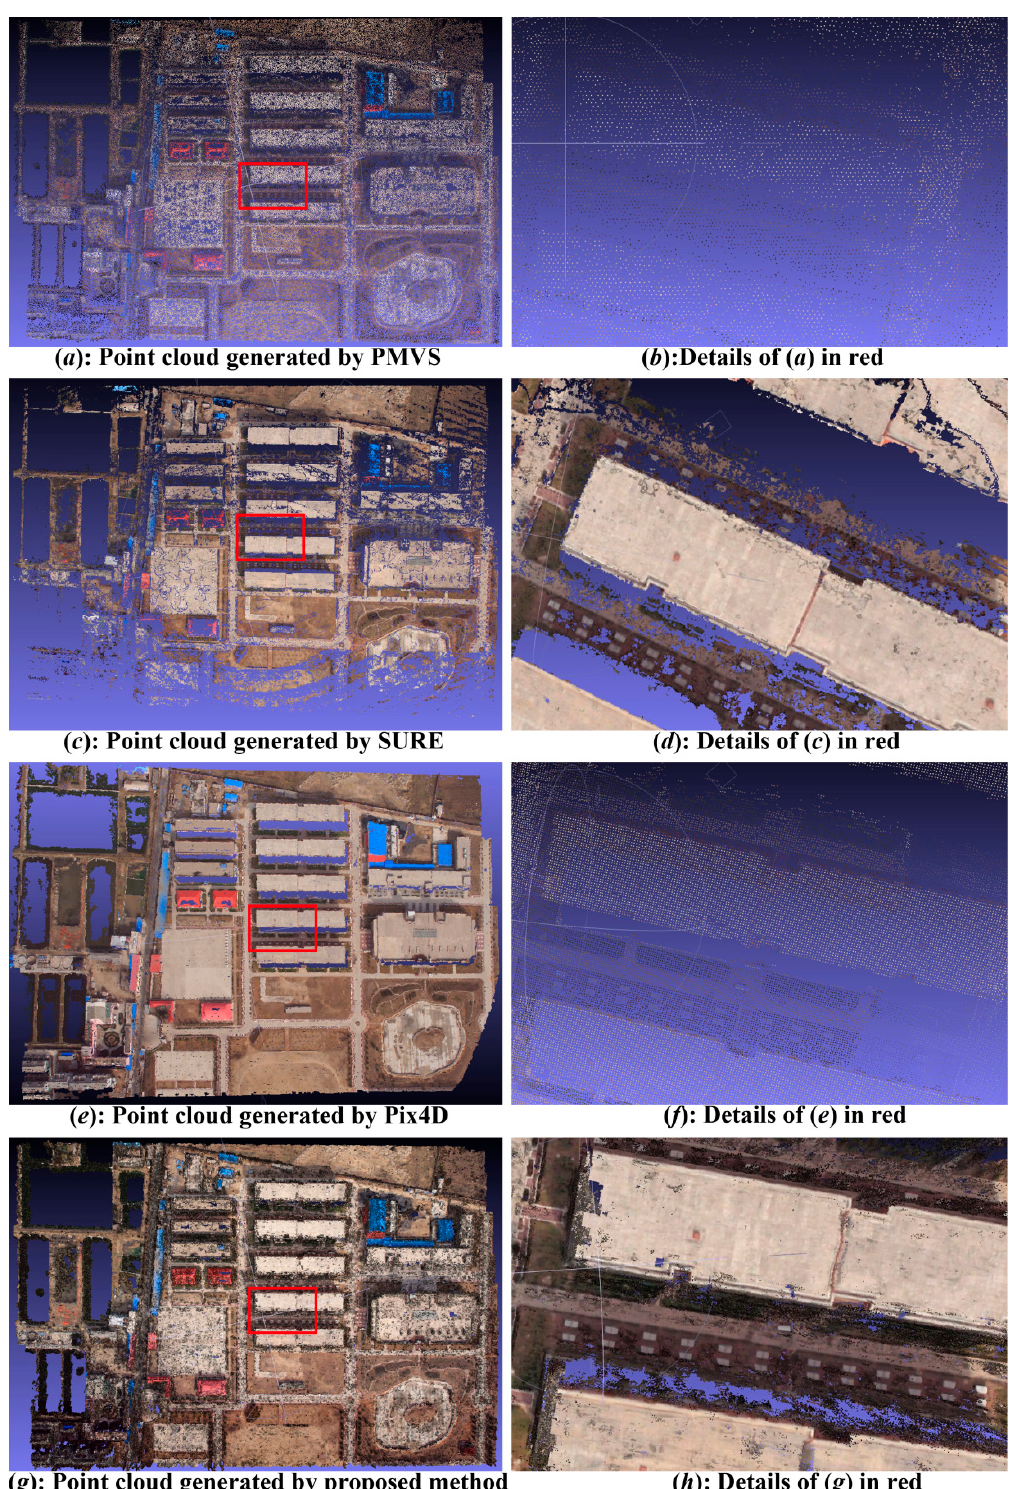
Figure 5. Examples of reconstructed point cloud with Northwestern University images illustrated by software MeshLab. ( a ) Point cloud generated by PMVS; ( b ) Details of ( a ) in red; ( c ) Point cloud generated by SURE; ( d ) Details of ( c ) in red; ( e ) Point cloud generated by Pix4D; ( f ) Details of ( e ) in red; ( g ) Point cloud generated by proposed method; ( h ) Details of ( g ) in red.